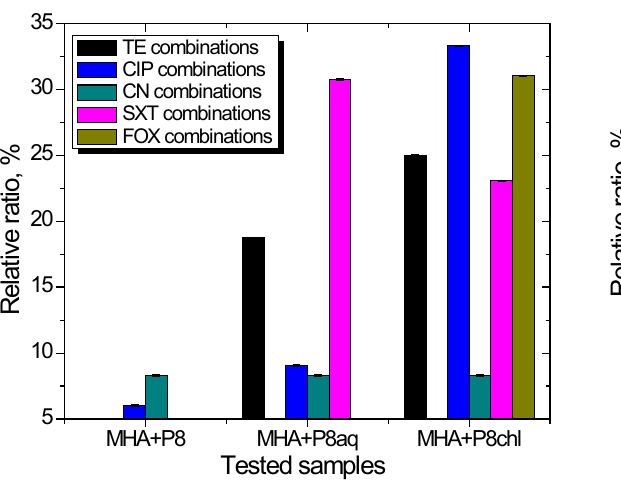
Figure 10 : P. aeruginosa ATCC 27853 response.